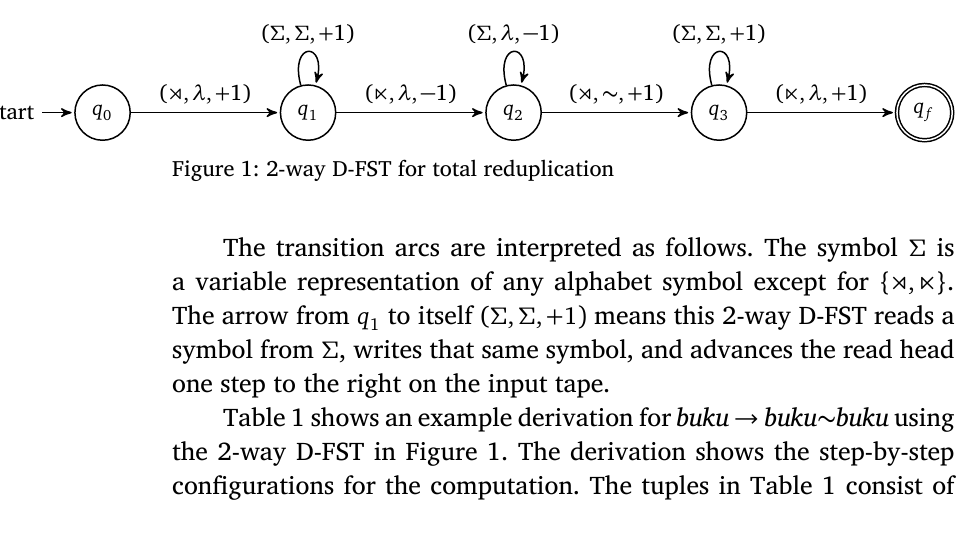
Table 1: Derivation of /buku/ ! [buku (cid:24) buku] Outputting the first